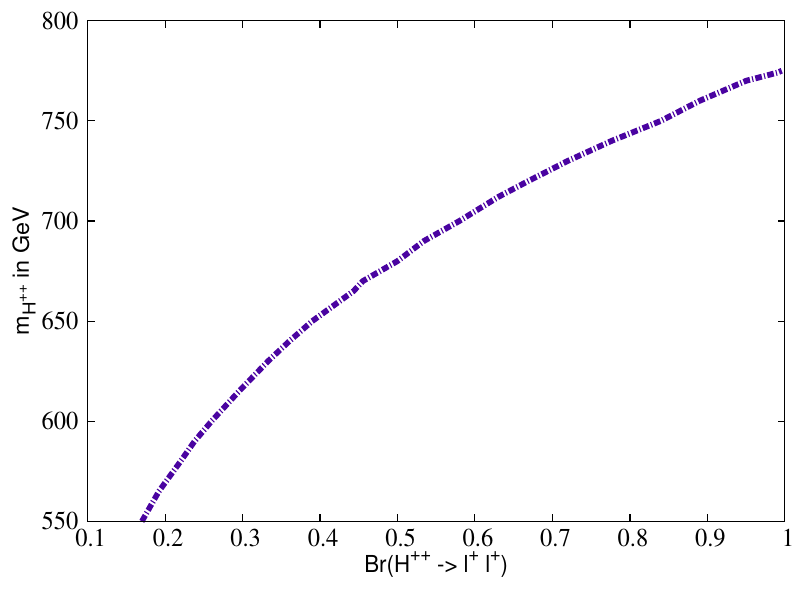
Figure 4 . Experimental lower limit on m